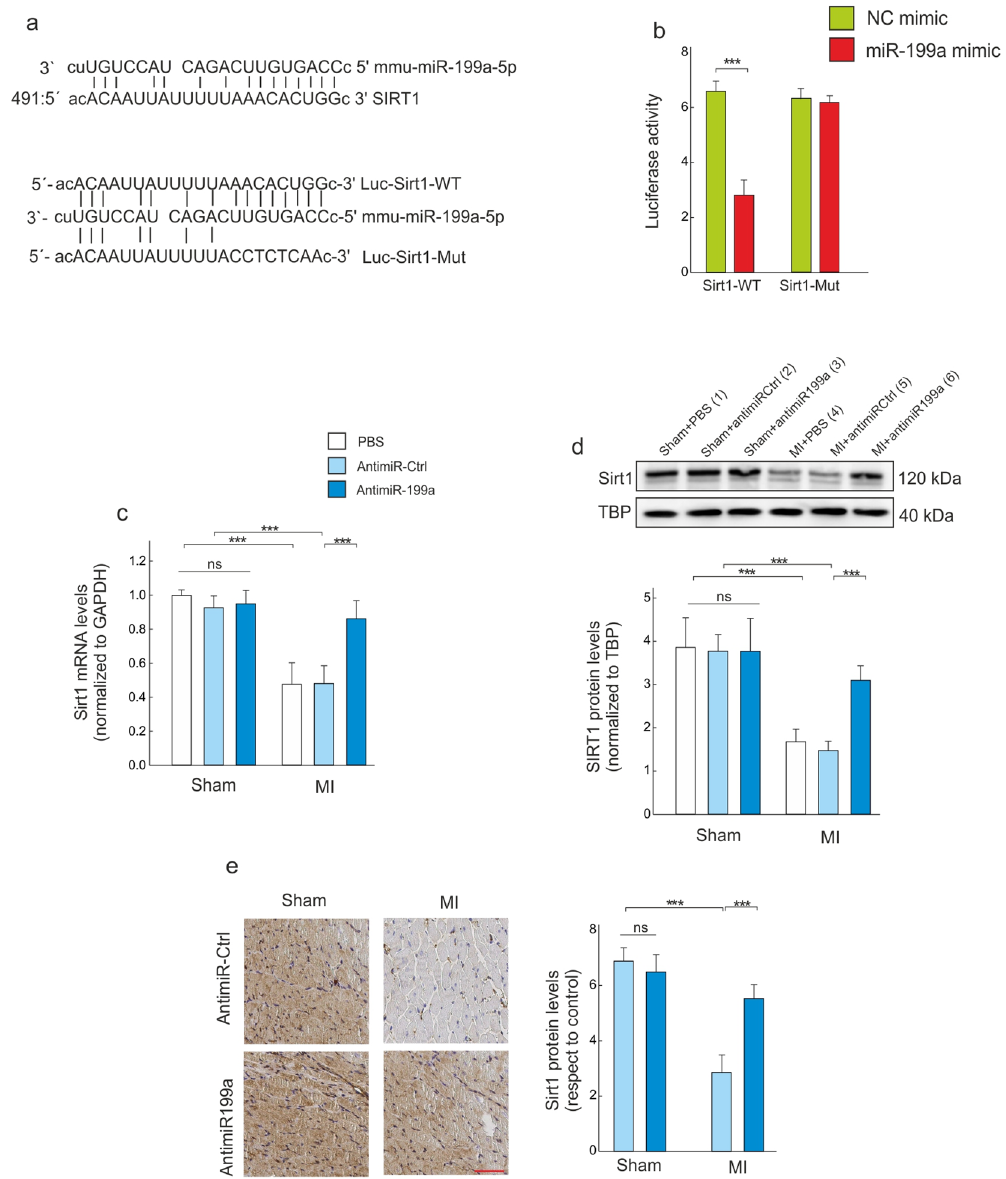
Figure 3. Pharmacological inhibition of miR-199a prevents Sirt1 down-regulation following MI. ( a ) Up: the putative miR-199a-5p binding sequence within the 3 ′ -UTR of Sirt1 mRNA; Down: the sequences and position of Sirt1 containing wild type and mutant binding site of miR-199a that cloned into the luciferase reporter vector. ( b ) Dual-luciferase reporter assay. ( c ) Determination of Sirt1 mRNA levels in the non-infarcted LV region 4 weeks after MI. ( d ) Sirt1 protein levels in the non-infarcted region 4 weeks after MI; Representative full western blot images are shown in supplementary material. ( e ) Assessment of Sirt1 protein levels by immunohistochemical analysis in the non-infarcted LV; Scale bar: 25 μm. All quantifications derive from n = 10 mice/group, PCR experiments were performed with 2 replicates each. All quantitative data are reported as means ± SEM. ***P < 0.001 determined by two-way ANOVA followed by Bonferroni’s post hoc test. GAPDH: Glyceraldehyde-3-Phosphate Dehydrogenase; TBP: TATA binding protein; other abbreviations as in Fig.